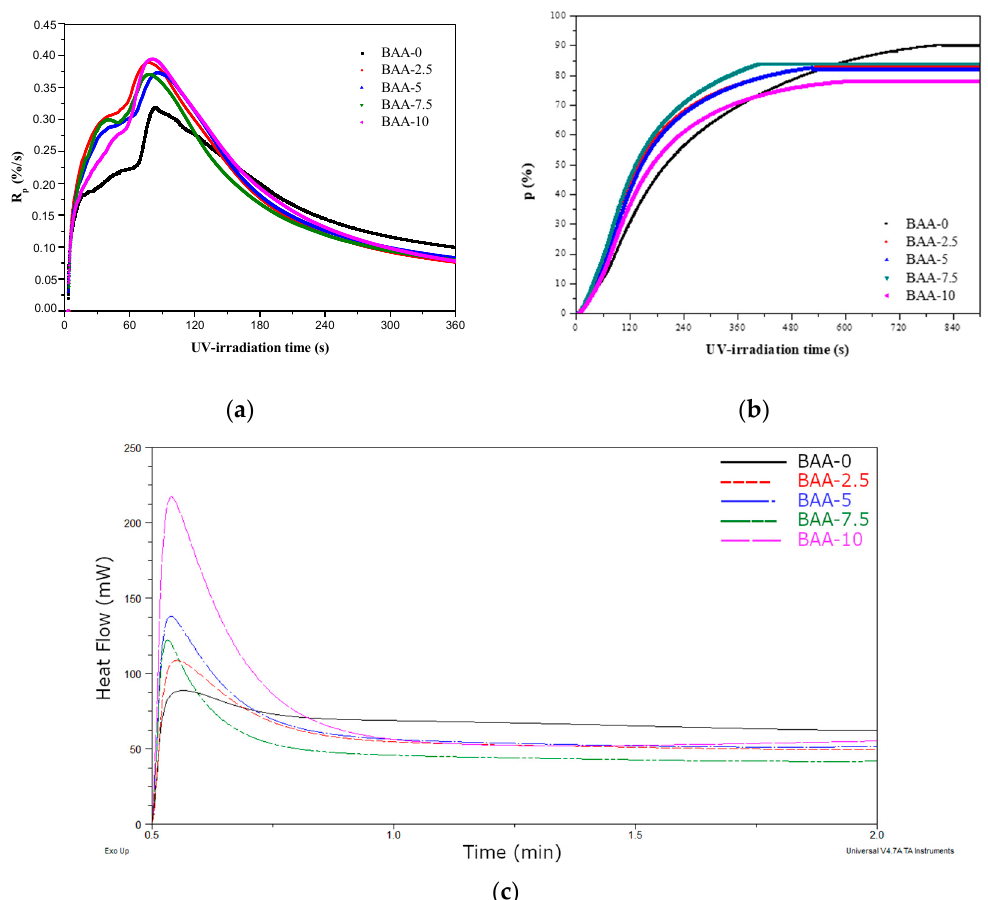
Figure 3. Cotelomerization rate curves ( a ), conversion spectra ( b ) and photo-DSC curves ( c ) of UV-induced cotelomerization of BA and ABP and various amount of AA in the presence of TPOL photoinitiator and CBr 4 (I 0 = 15 mW / cm 2 ; 320–390 nm).